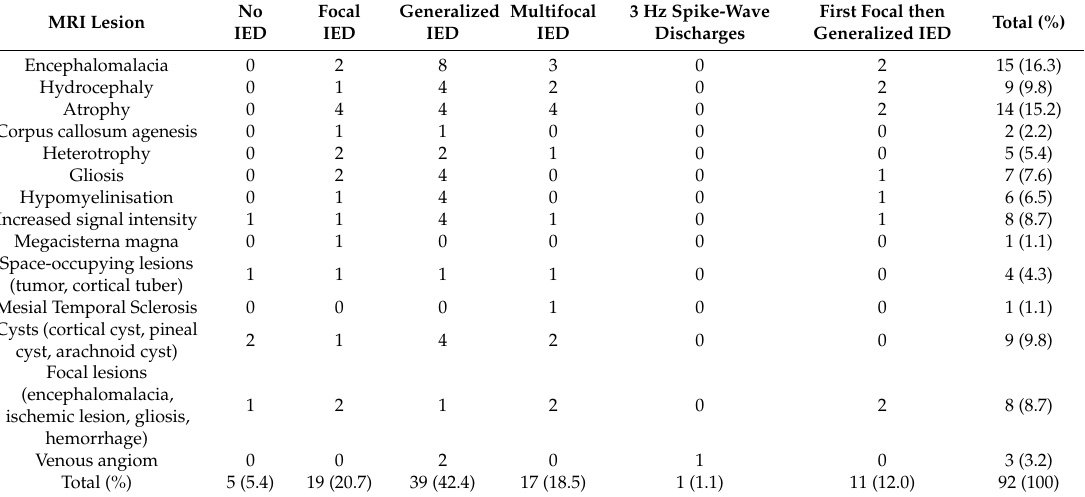
Table 4. Electroencephalography (EEG) discharges in relation to magnetic resonance imaging (MRI) lesions. No MRI Lesion